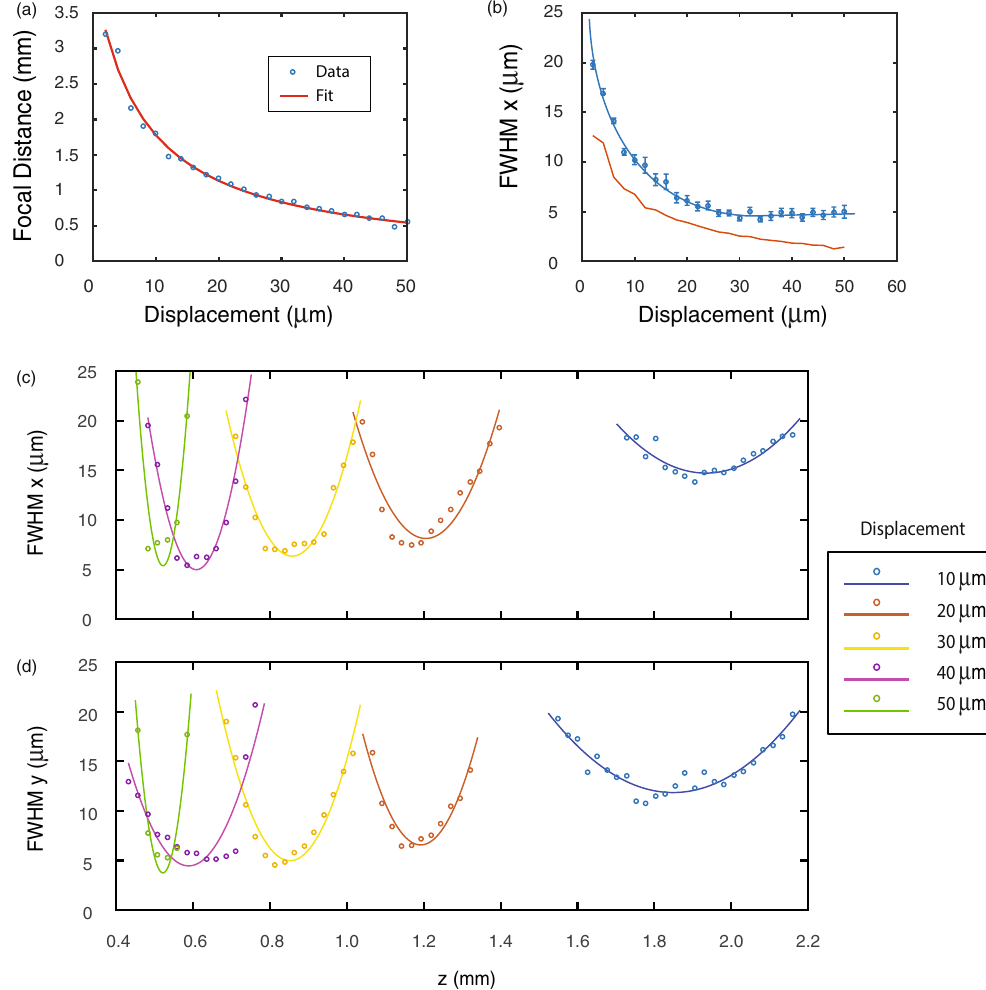
Figure 5. Alvarez lens performance. ( a ) Measured focal distance of the Alvarez lens pair plotted against x displacement. The red line is a theoretical fit to the focal length data. ( b ) Full width at half maximum (FWHM) measured along the x axis plotted against x displacement. The measured data are shown as blue points while the blue line is an eye guide. The diffraction-limited spot size FWHM is plotted in red. Error bars represent a 95% confidence interval of a Gaussian fit. For both ( a ) and ( b ) images were taken with a displacement step size of 2 μ m. ( c , d ) Behavior of the Alvarez lens FWHM for five displacements along x-axis. The FWHM of the spot-size in the sensor plane is plotted as the microscope moves into and out of the focal plane. The FWHMs are measured along the ( c ) x and ( d ) y axes. FWHM data is plotted as the points, and the lines are eye